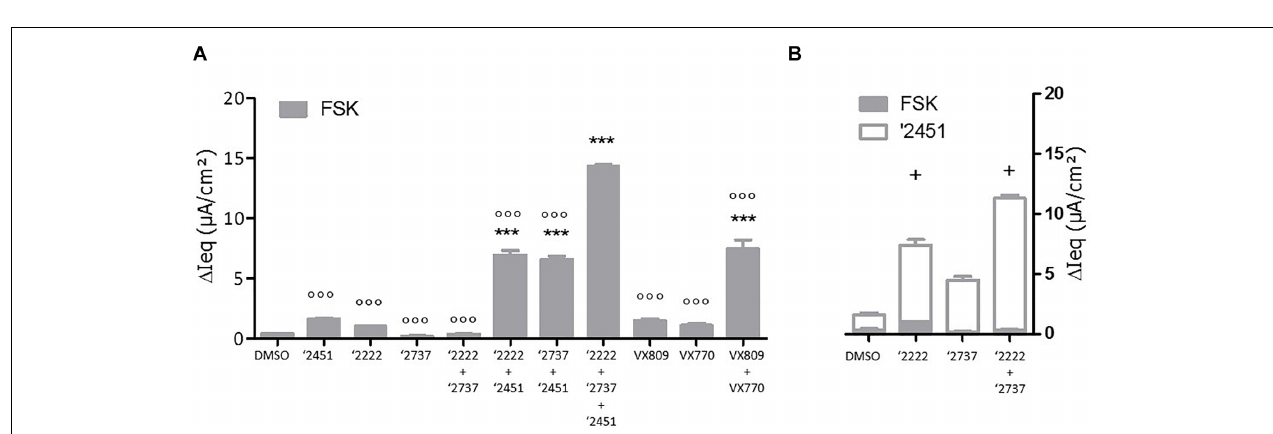
FIGURE 3 | Effects of GLPG2737 on F508del CFTR maturation and function. (A) Dose–response of GLPG2737 after 24 h treatment in CSE-HRP assay, % F508del CFTR expression at plasma membrane (PM) was normalized to control compound 15 (derived from GLPG2222 series) in (A–D) and each concentration was tested in duplicate. (B) Dose–response of GLPG2737 in combination with 0.5 µ M compound 15 (derived from GLPG2222 series) after 24 h treatment in CSE-HRP assay. (C) Dose–response of GLPG2737 after 24 h treatment in CSE-MEM assay. (D) Dose–response of GLPG2737 in combination with 0.5 µ M GLPG2222 after 24 h treatment in CSE-MEM assay. (E) CSE-MEM cells were incubated with compound for 24 h. Cell lysates were loaded on gel and Band B/C was detected using 596 antibody (Band C, mature complex-glycosylated F508del CFTR; Band B, immature core-glycosylated CFTR. (F) F508del/F508del HBE cells were incubated with indicated corrector compound(s) for 24 h, CFTR channel was activated with 10 µ M forskolin and 1.5 µ M potentiator. ∗∗∗ denotes a p -value < 0.001 compared to DMSO treatment. ◦◦◦ denotes a p -value < 0.001 compared to GLPG2222 + GLPG2737 treatment. (G) Average of raw traces of experiments represented in F ( n = 3–6 for each condition in F and G ) (H) Dose–response of 24 h treatment with GLPG2737 in combination with 0.15 µ M GLPG2222 (black) or without (gray) and 1.5 µ M GLPG3067 (tested in duplicate for each concentration).